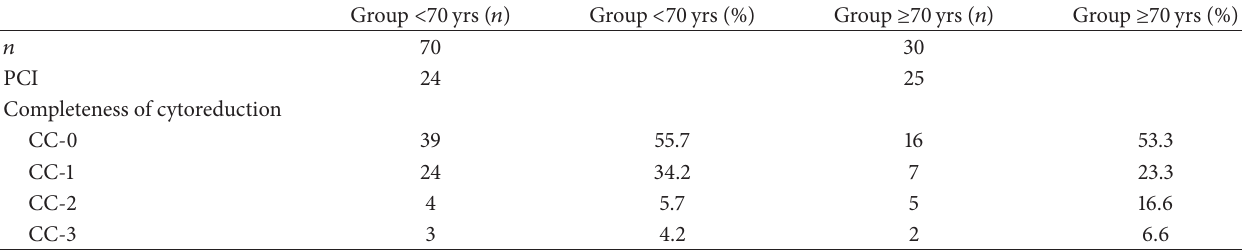
Table 2: Comparison of intraoperative characteristics between the groups older and younger than 70 years.